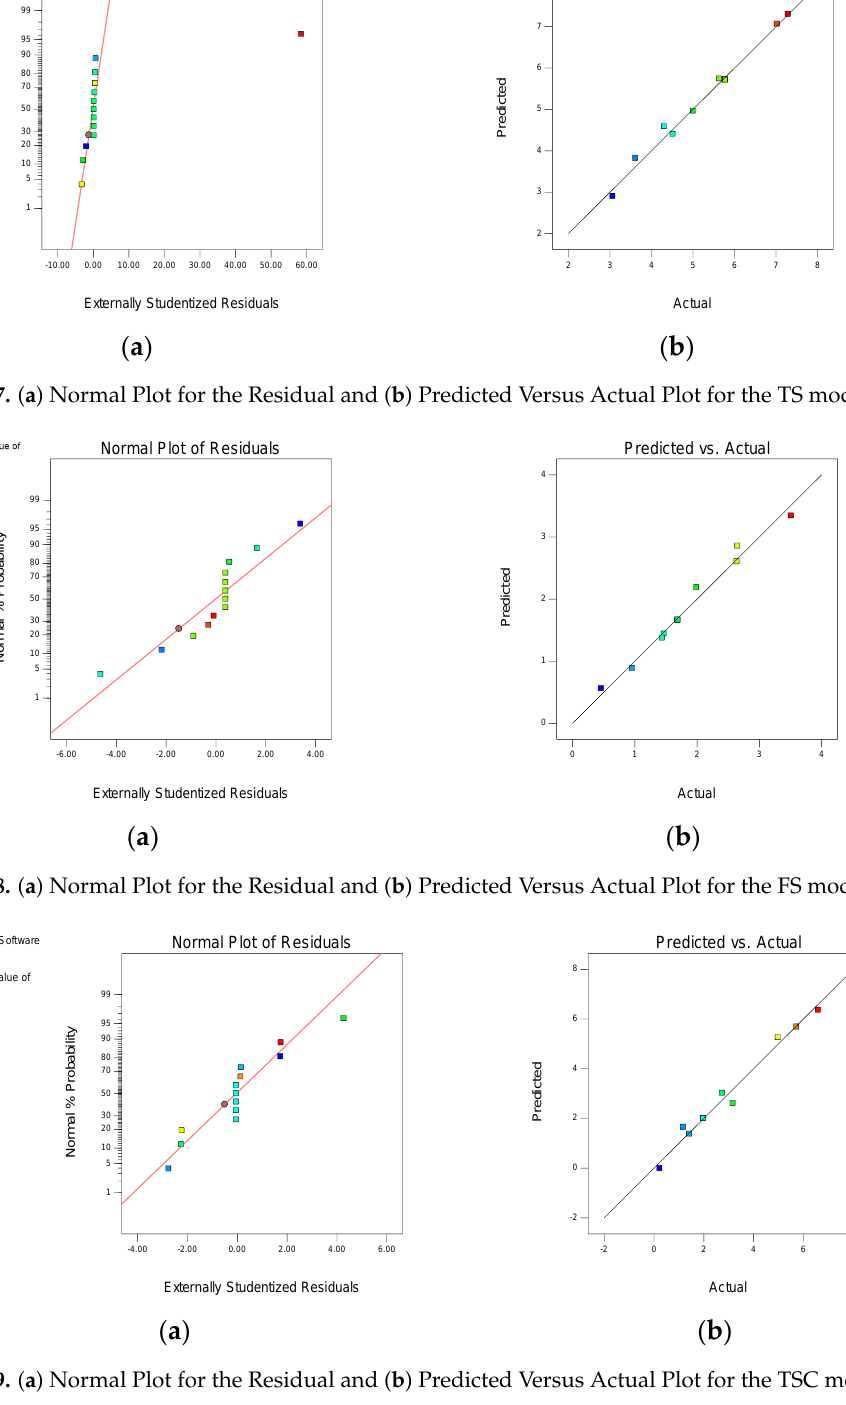
Figure 19. ( a ) Normal Plot for the Residual and ( b ) Predicted Versus Actual Plot for the TSC model. Other vital tools used to assess the interaction between the variables are the model graphs, which include the 2D contour and the 3D response-surface diagrams. As shown in Figures 20–23, these plots are color-coded to show the influence of the interaction of the input factors on the responses. Red regions represent areas with high response intensity, while blue regions represent low response magnitudes. The intermediate response values are represented by the yellow and green regions. For example, Figure 20a,b depict the 2D contour and 3D response diagrams for compressive strength. The figures reveal a significant increase in compressive strength with decreasing amounts of POFA and